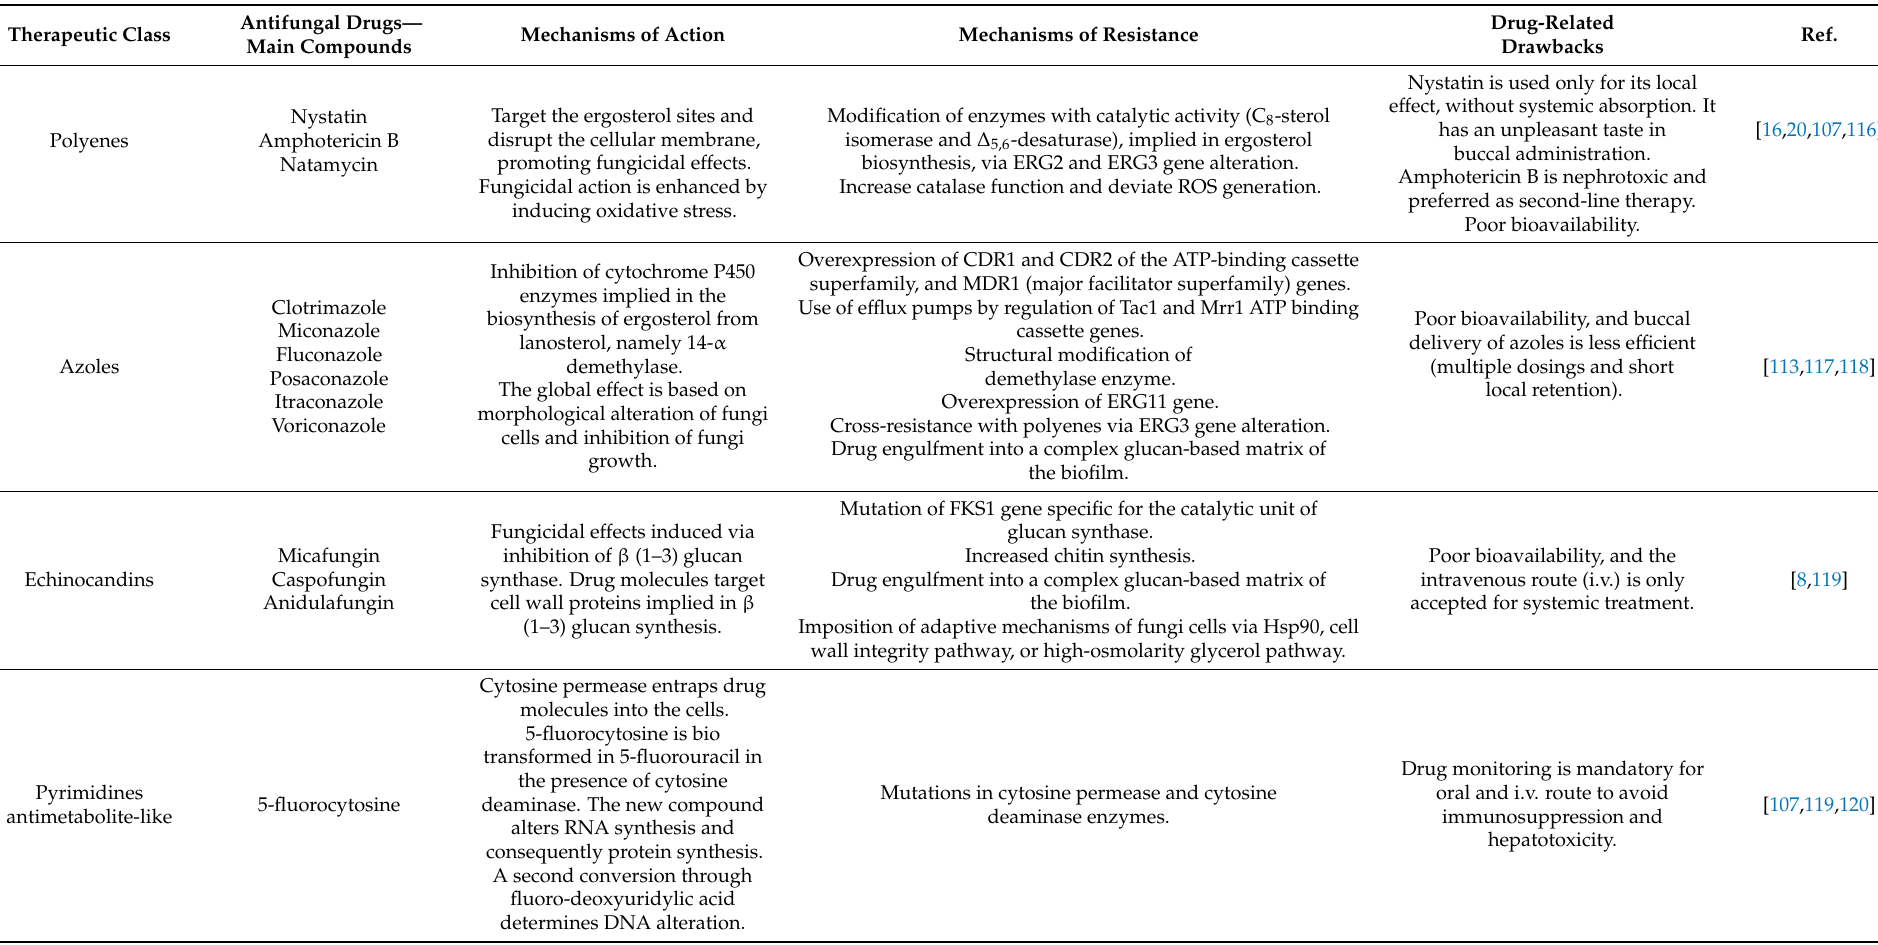
Table 2. Classic antifungal drugs, their mechanisms of action, and major drawbacks in terms of fungal resistance to antifungal